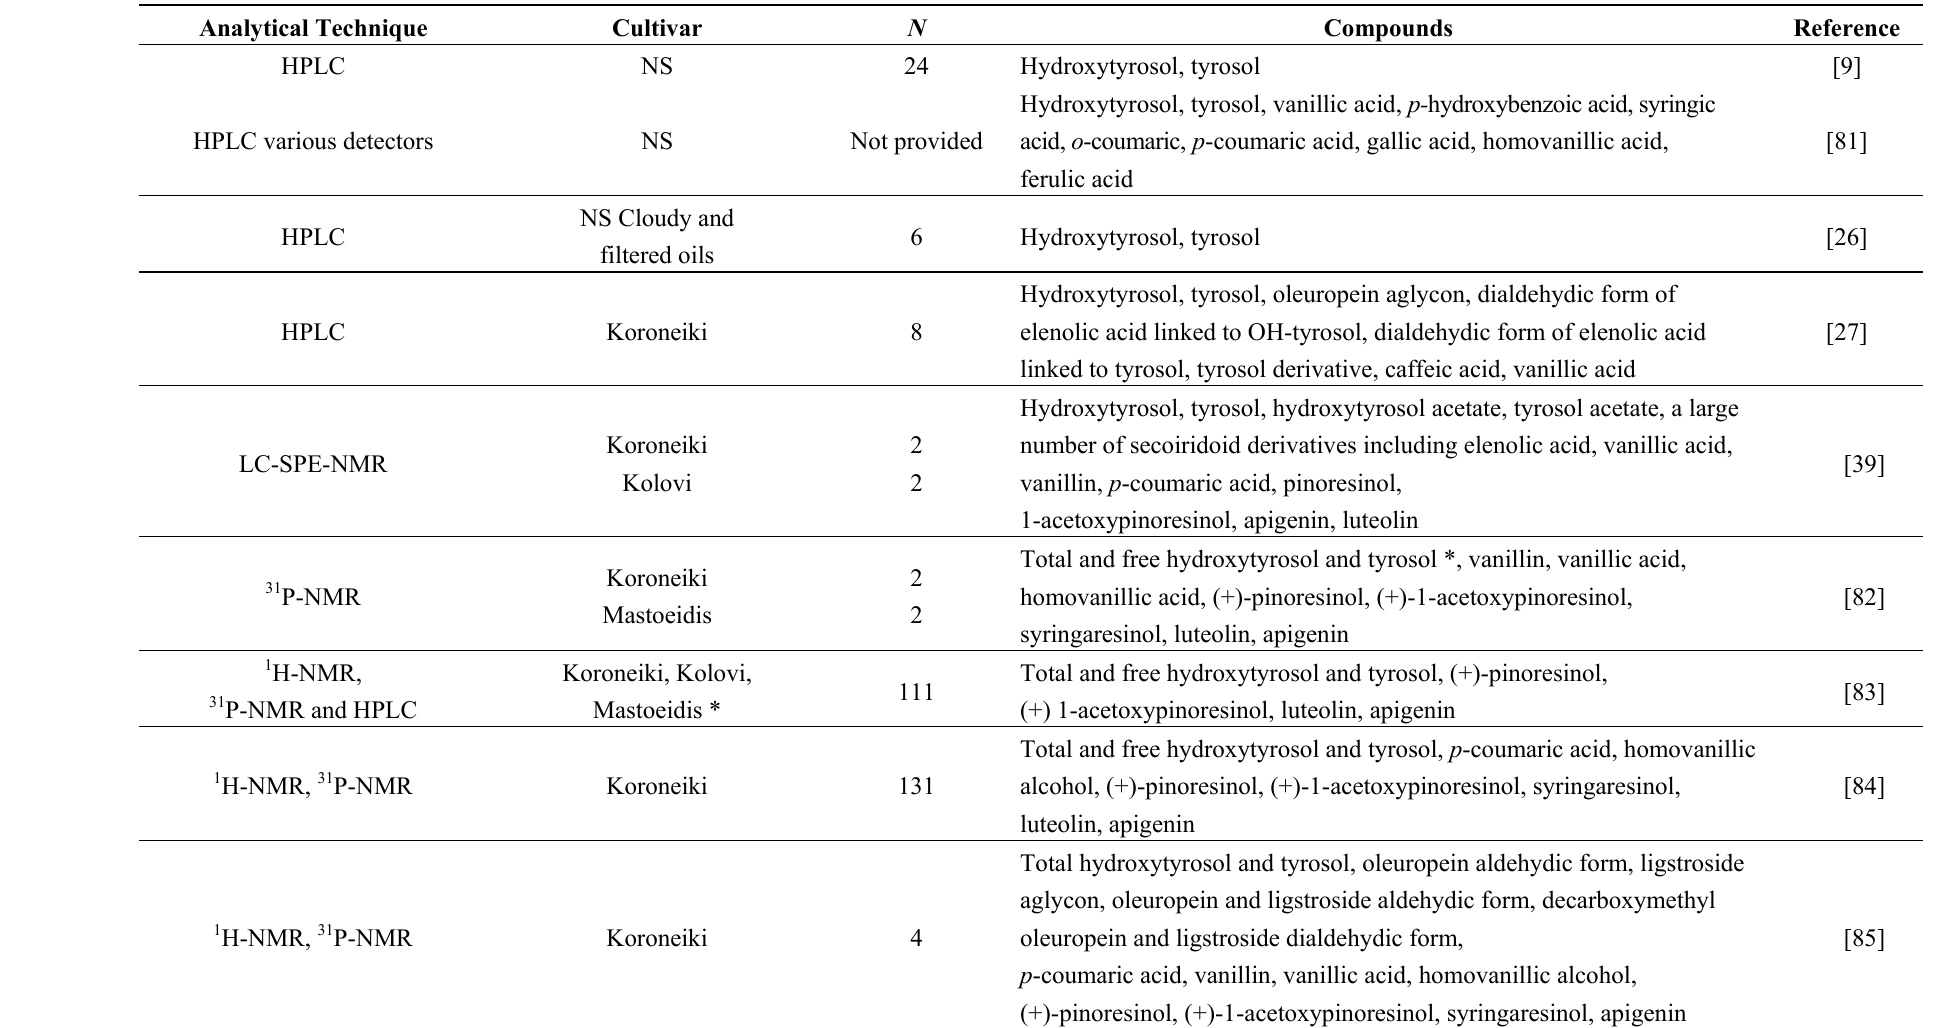
Table 2. Individual phenolic compounds reported in Greek virgin olive